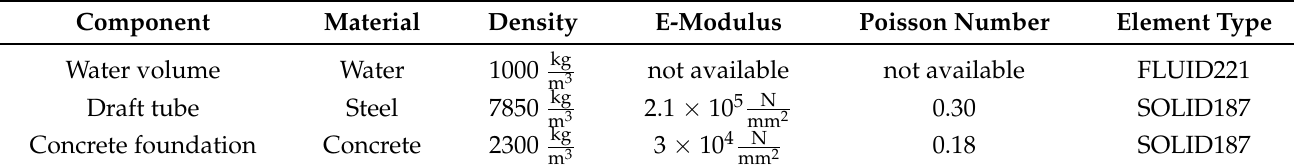
Table 4. Summary of materials and element